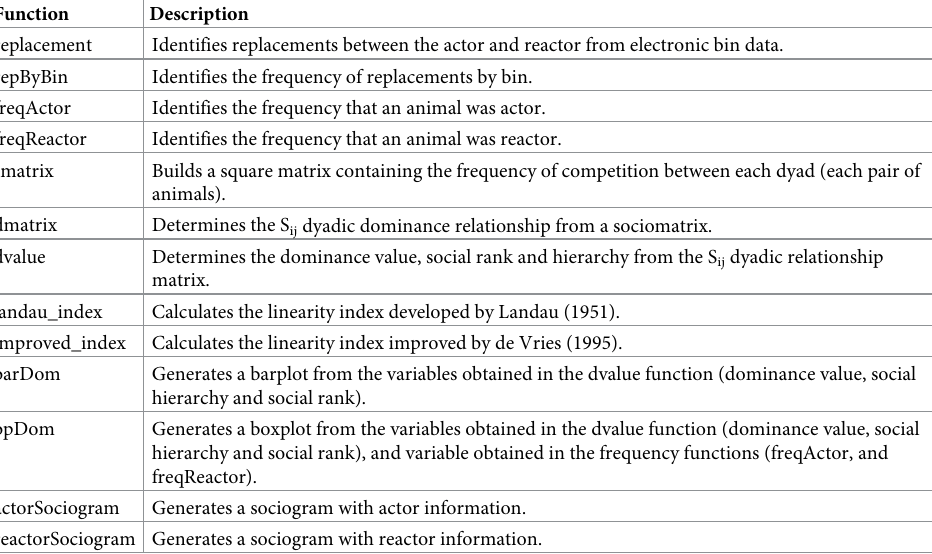
Table 1. Descriptions of functions of the socialh R